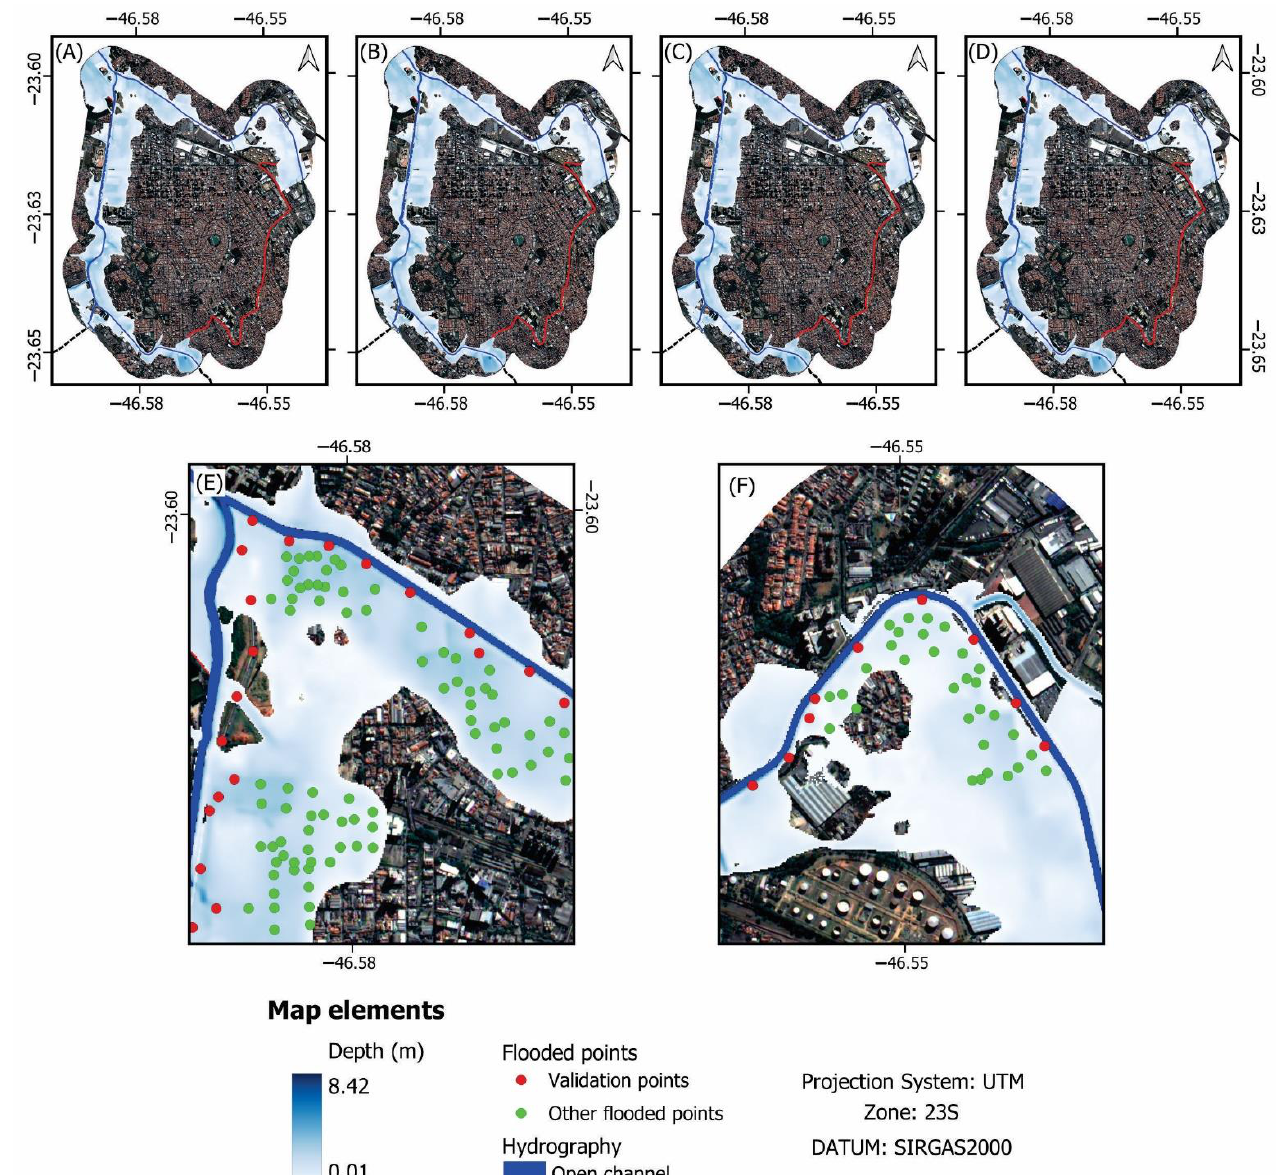
Figure 8. Flood maps generated in HEC-RAS. ( A – D ) represent the simulations with the computing interval of 1, 15, 30, and 60 s, respectively, with the EMPLASA DTM (5 m). ( E ) is a zoom-in of the confluence of Tamanduateí River and Meninos Brook in the northwestern region of the study area. ( F ) shows a zoom-in of Tamanduateí River in the northeastern part of the analyzed reach. Red points are used for validation, while the green points represent other flooded points reported by the citizens of São Caetano do Sul. The thick lines in dark blue correspond to the open channels. The different shades of blue in polygonal shape account for the different depths of the flood zones.